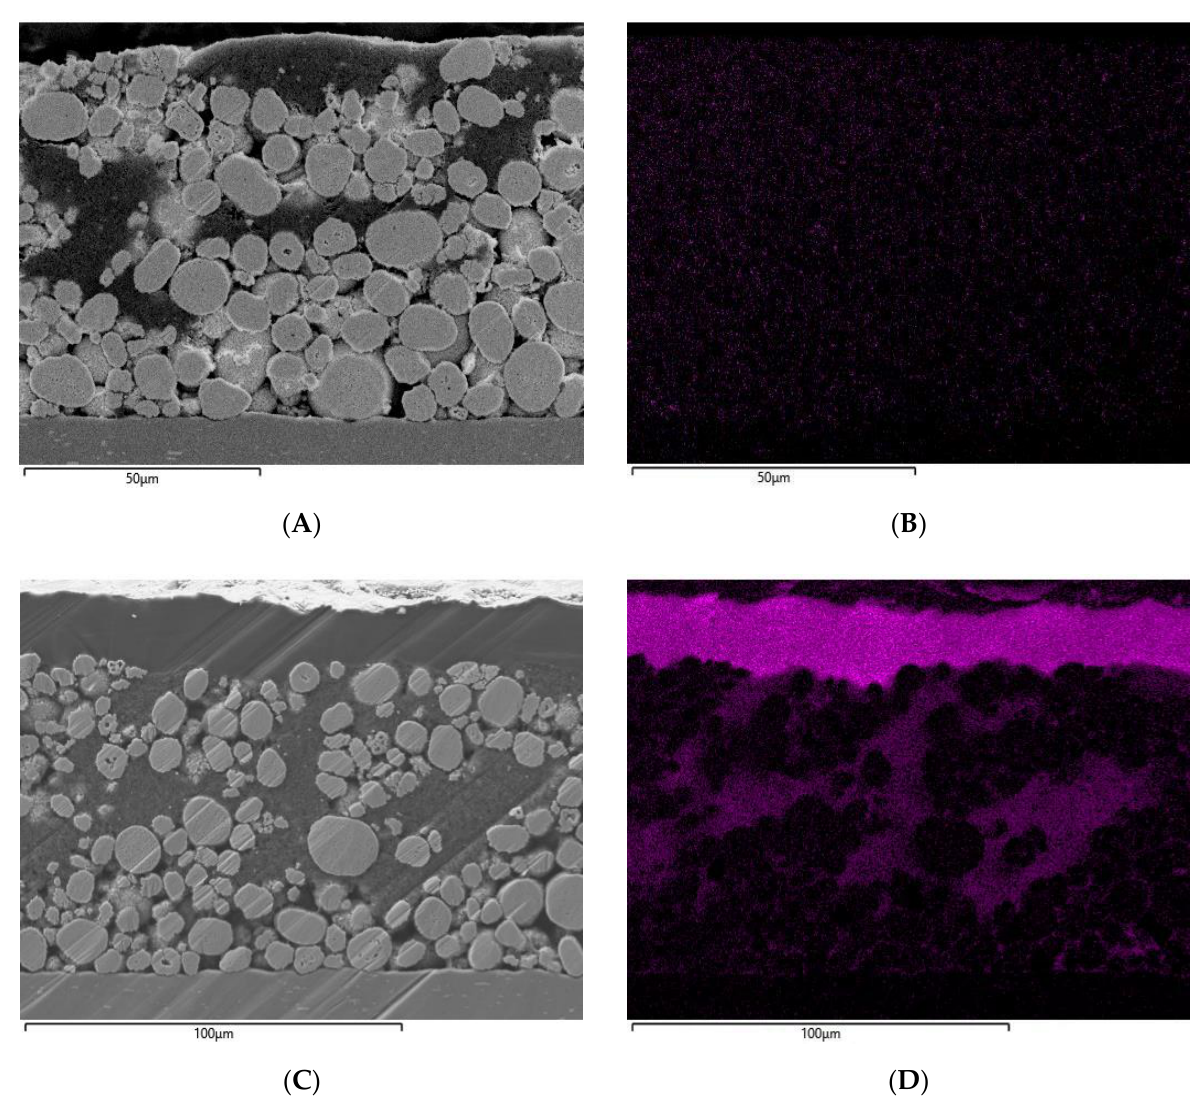
Figure 7. FESEM cross-section (SE-detector) prepared by focused ion beam of: ( A ) sample of pristine NCM without PCPE; ( B ) EDS mapping of sulfur in pristine NCM (control sample); ( C ) infiltrated and laminated NCM sample with PCPE; ( D ) EDS mapping of sulfur in infiltrated and laminated NCM.